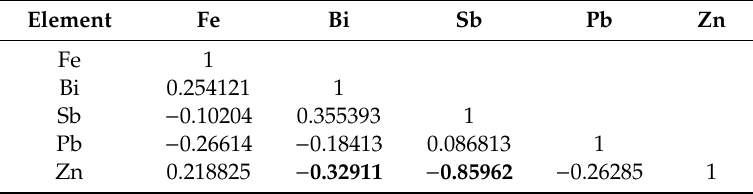
Table 3. Cross-correlation matrix between the elements identified during microprobe analysis. The statistically significant (p < 0.05) correlations are marked with bold letters. Element Fe Bi Sb